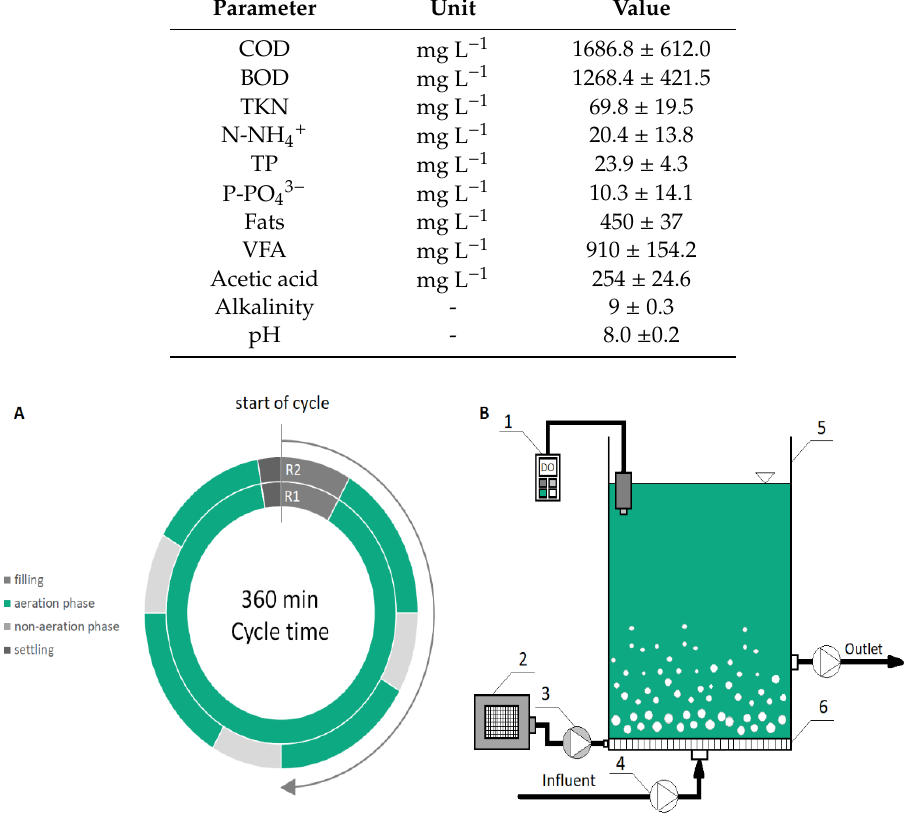
Figure 1. Organization of reactors cycle ( A ) and a scheme of the reactors: 1—Oxygen detector, 2—Compressor, 3—Air pump, 4—Peristaltic pump, 5—Reactor, 6—Fine bubble di ff user ( B